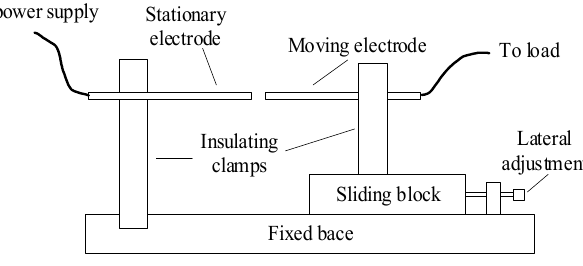
Figure 7. Schematic diagram of the DC series arc fault experimental platform.